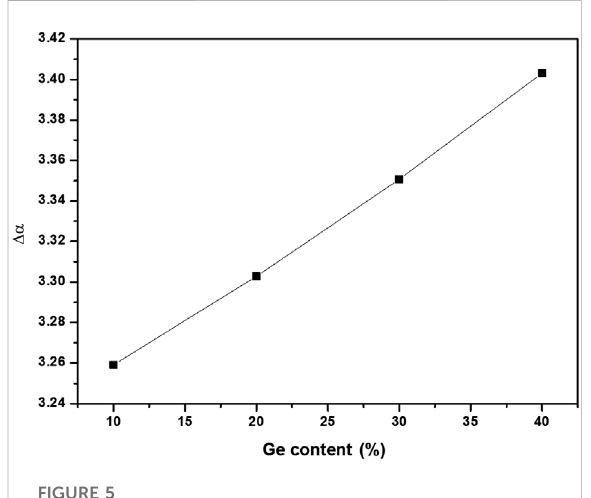
Simulation curve of Ge content and absorption coef fi cient at 2 μ m wavelength.